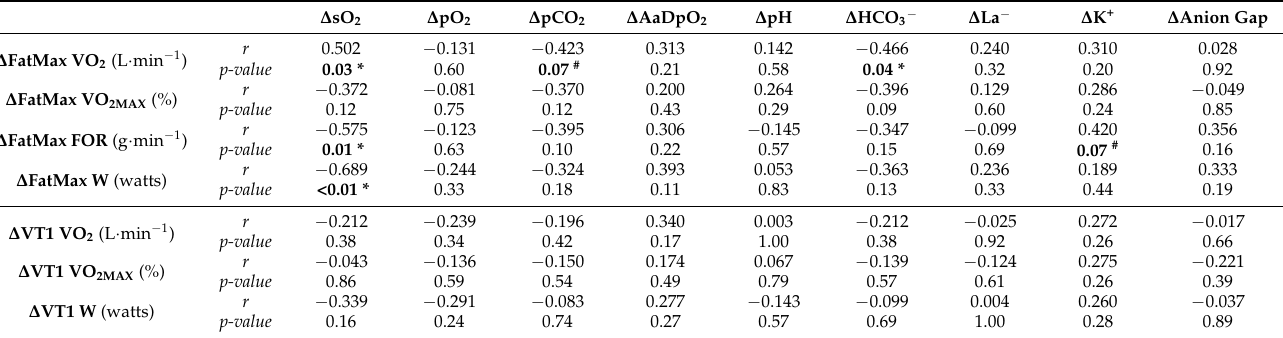
Table 7. Correlations of the start–end off-season differences between performance-metabolic variables and blood gas markers in well-trained